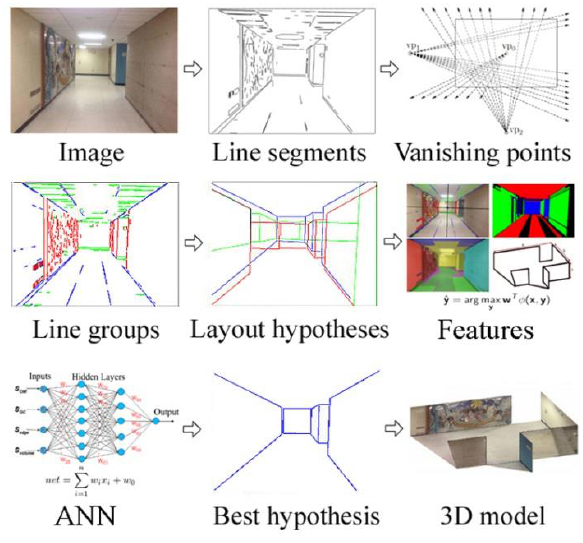
Figure 2. The method detects edges and groups them into line segments. It estimates vanishing points, and creates layout hypotheses. It uses the scoring function (parameters optimized by ANN) to evaluate hypotheses, and finally converts the best hypothesis into a 3D